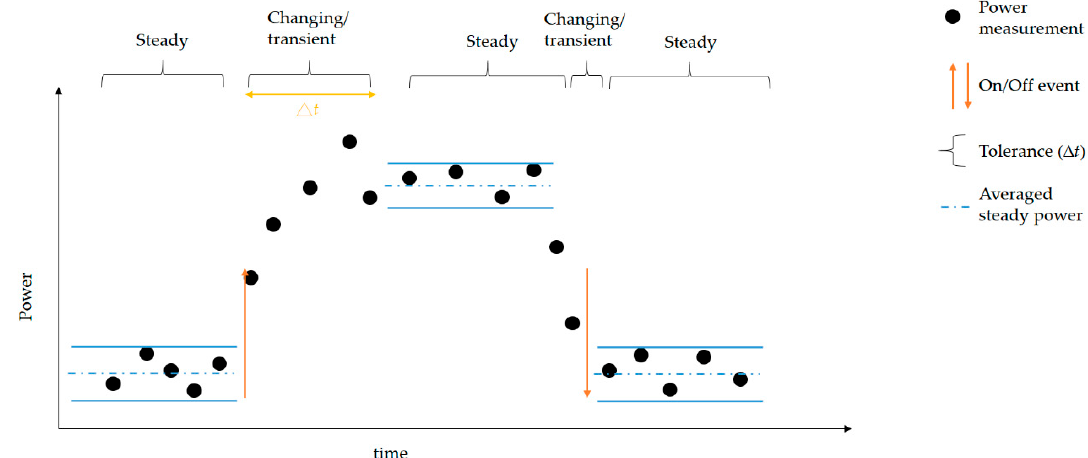
Figure 6. Detecting an appliance event in acquired total energy consumption through transient-passing event detection.